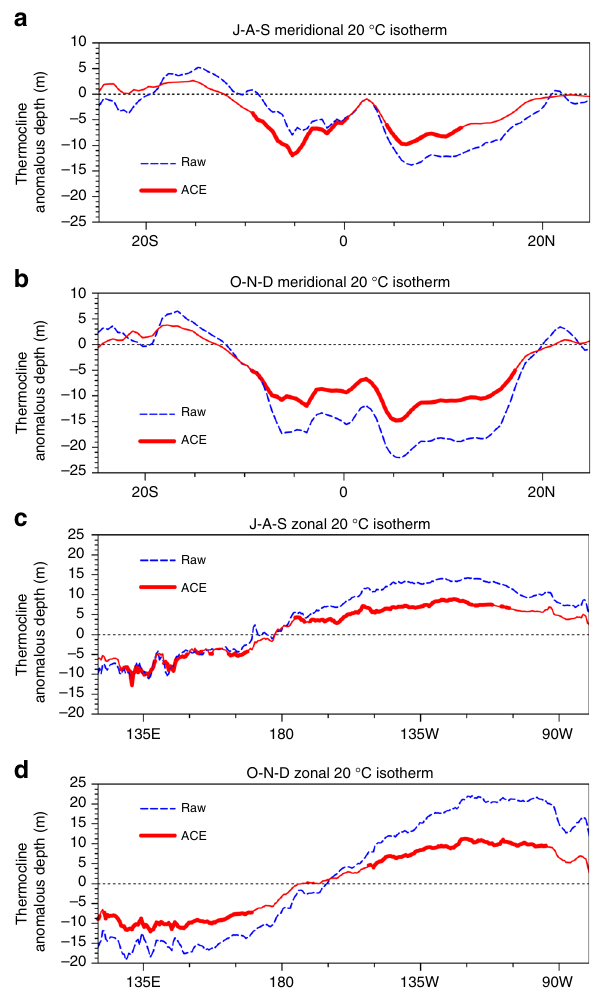
Fig. 4 Thermocline (20°C isotherm depth, m) during El Niño developing years (1970 – 2010). a Meridional distribution (along 135° – 170°E) in J – A – S. b As in a , but for O – N – D. c , Zonal distribution (along 5°S – 5°N) in J – A – S. d As in c , but for O – N – D. The blue dashed line indicates the original thermocline; the red line associated with the preceding WNP ACE signal in J – A – S, and the thicker line indicates signi fi cance above the 95% con fi dence level. An El Niño developing year is de fi ned when the above-moderate